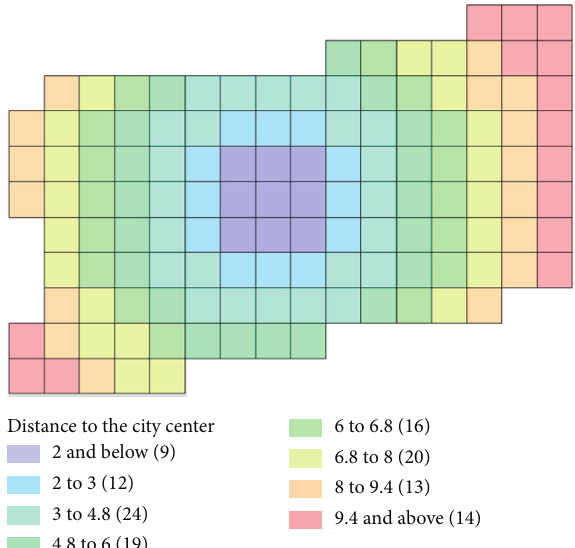
Figure 6: Distance to the city center (unit: mile).